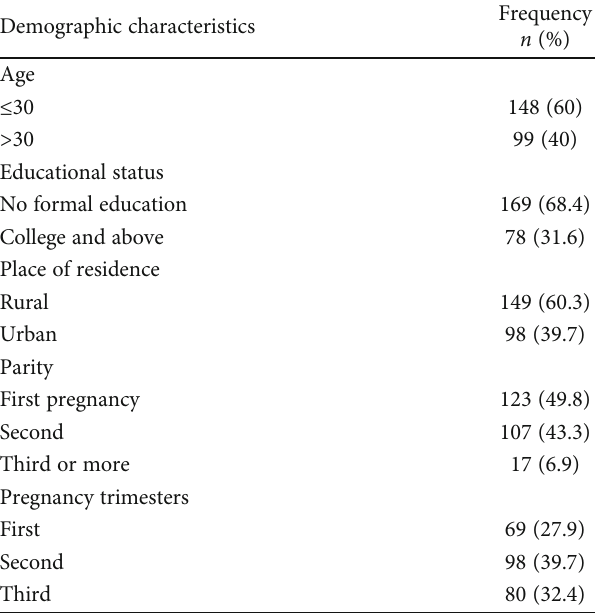
Table 1: Demographic characteristics of study